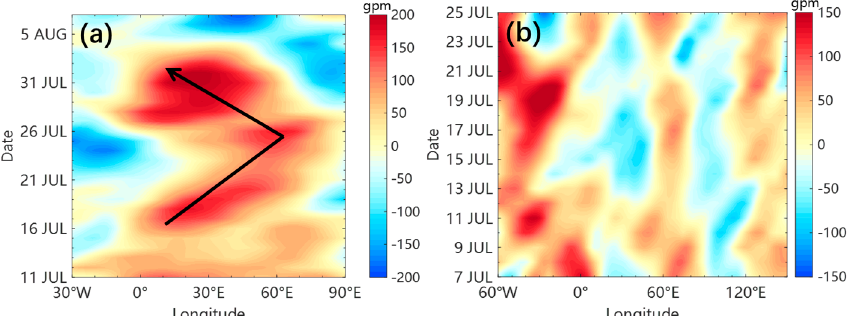
Figure 8. Time-longitude evolution of the 500 hPa geopotential height anomalies averaged over the latitudes 60°–75° N and 40°–55° N, representing the evolution of ( a ) the blocking and ( b ) the wave train, respectively. The thick black arrow in (a) denotes the movement of the blocking.